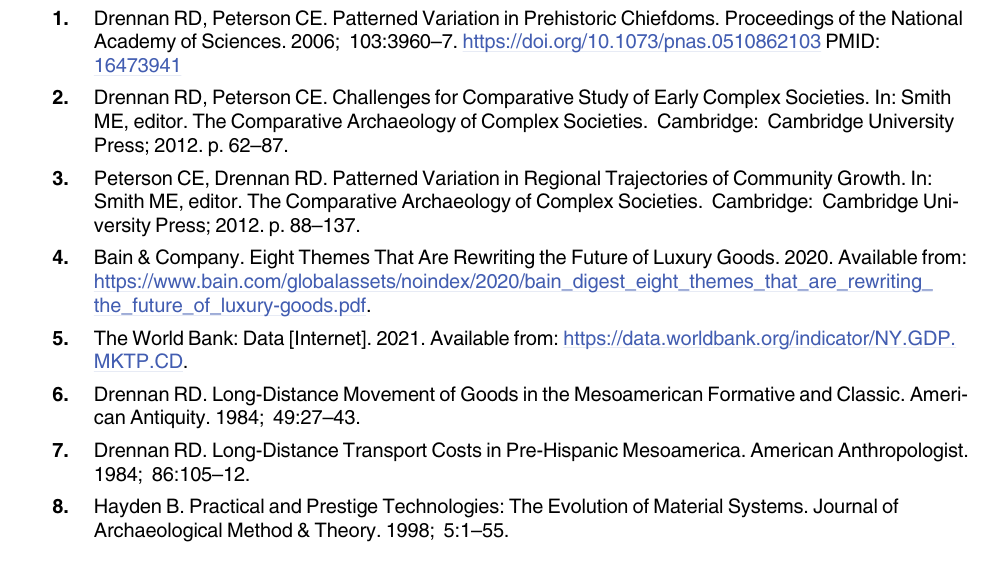
S2 Table. Multidimensional scaling configurations. The results of the multidimensional scal- ing analyses that were, in turn, the input for the k -means analyses are provided in a single spreadsheet file with six worksheets, one for each site, with the coordinates in two dimensions for the points in the scaling configuration. A final column contains the cluster number for each case in the k -means analysis (the central cluster is always No. 1). S1 Text. Sources of household assemblage artifact data. Information on each of the six sites whose household assemblage artifact data were the input for the multidimensional scaling analyses, along with a list of the variables used in those analyses, is provided in a single docu-